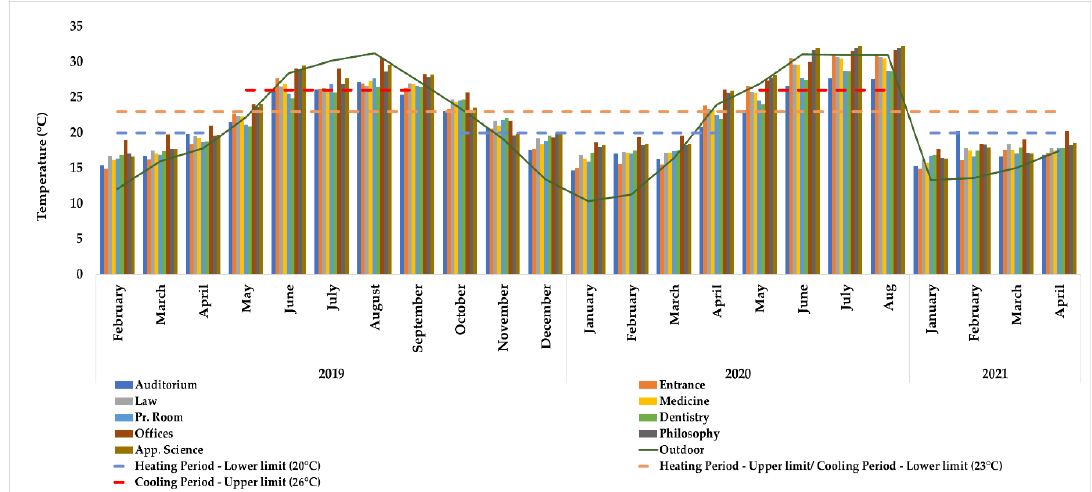
Figure 4. Mean monthly average temperature (°C) values within the museum along with the respective limits.